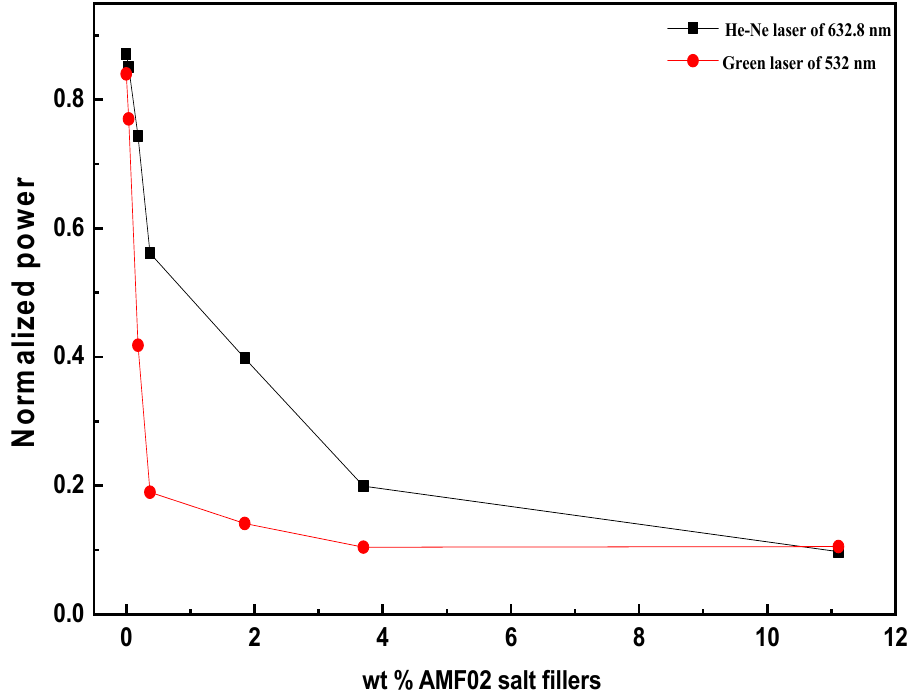
Figure 9. Optical power limiting by using two laser sources (He-Ne 632.8 nm laser and solid-state laser green diode 532 nm laser beam) for various samples.